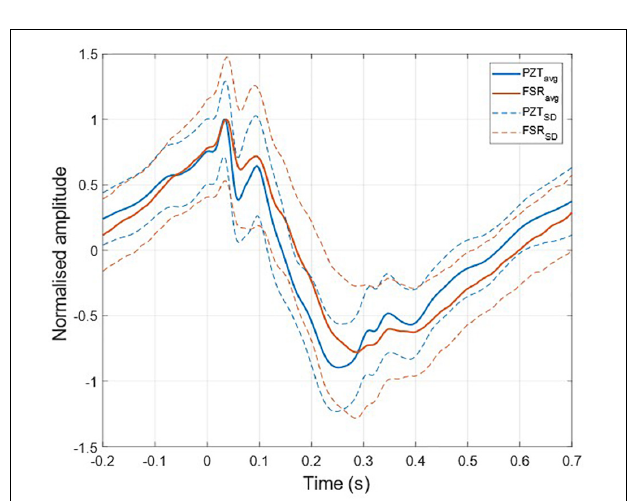
FIGURE 6 | ECG-triggered ensemble averages of FCG signals from FSR and PZT sensors computed on 220 heartbeats. The time 0 corresponds to the location of the ECG R-peak. Ensemble averages are depicted with solid lines, while the limits of the ± SD ranges are depicted with dotted lines. For each sensor signal, the ensemble average and the limits of the ± SD ranges were normalized to the maximum of the ensemble